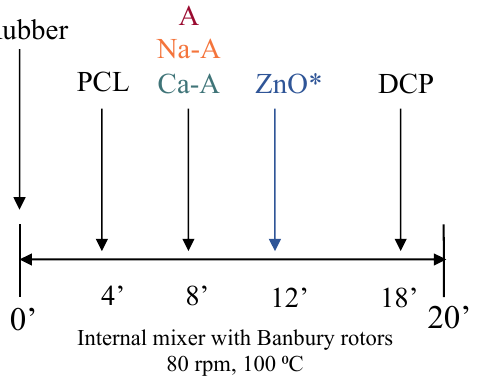
Figure 2. Scheme of the internal mixing process. (*) ZnO was only added in compounds with A.